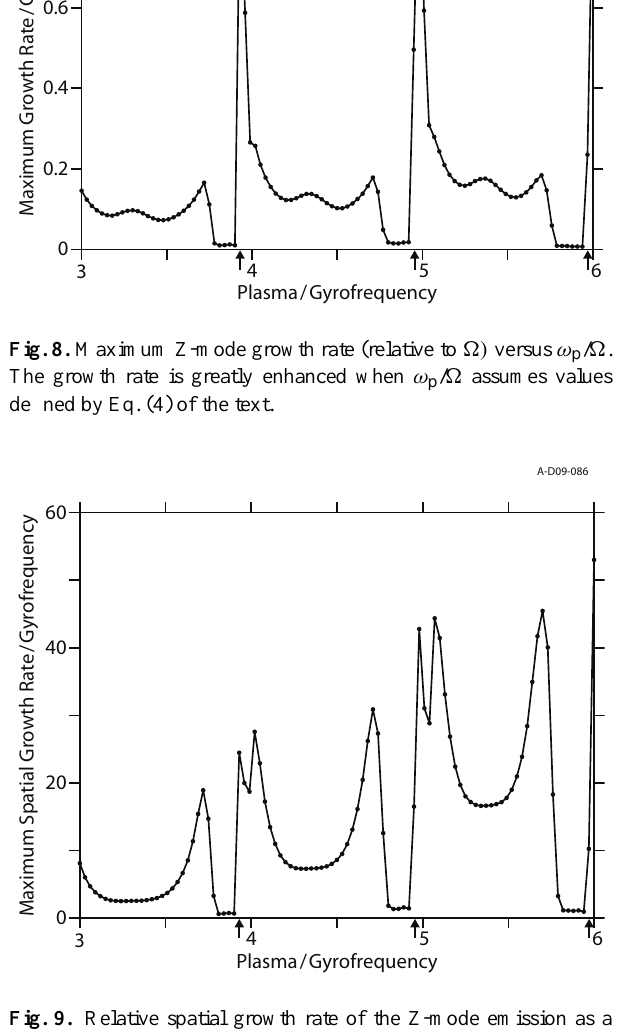
Fig. 9. Relative spatial growth rate of the Z-mode emission as a function of ω p / (cid:127) .